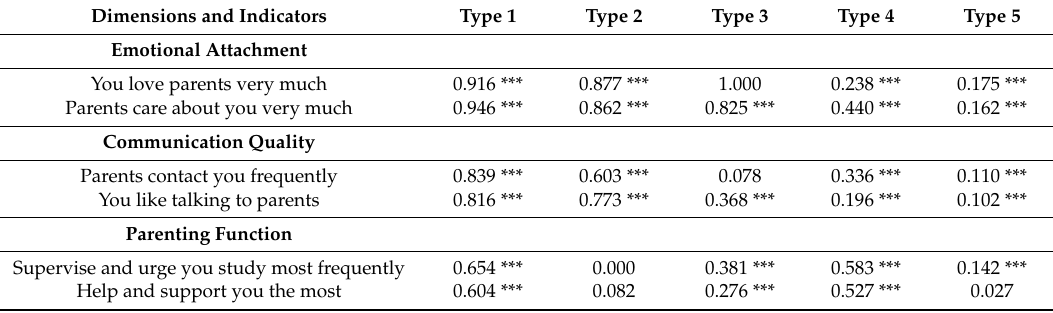
Table 6. Latent class coe ffi cients for five-class model of parent-child relations.